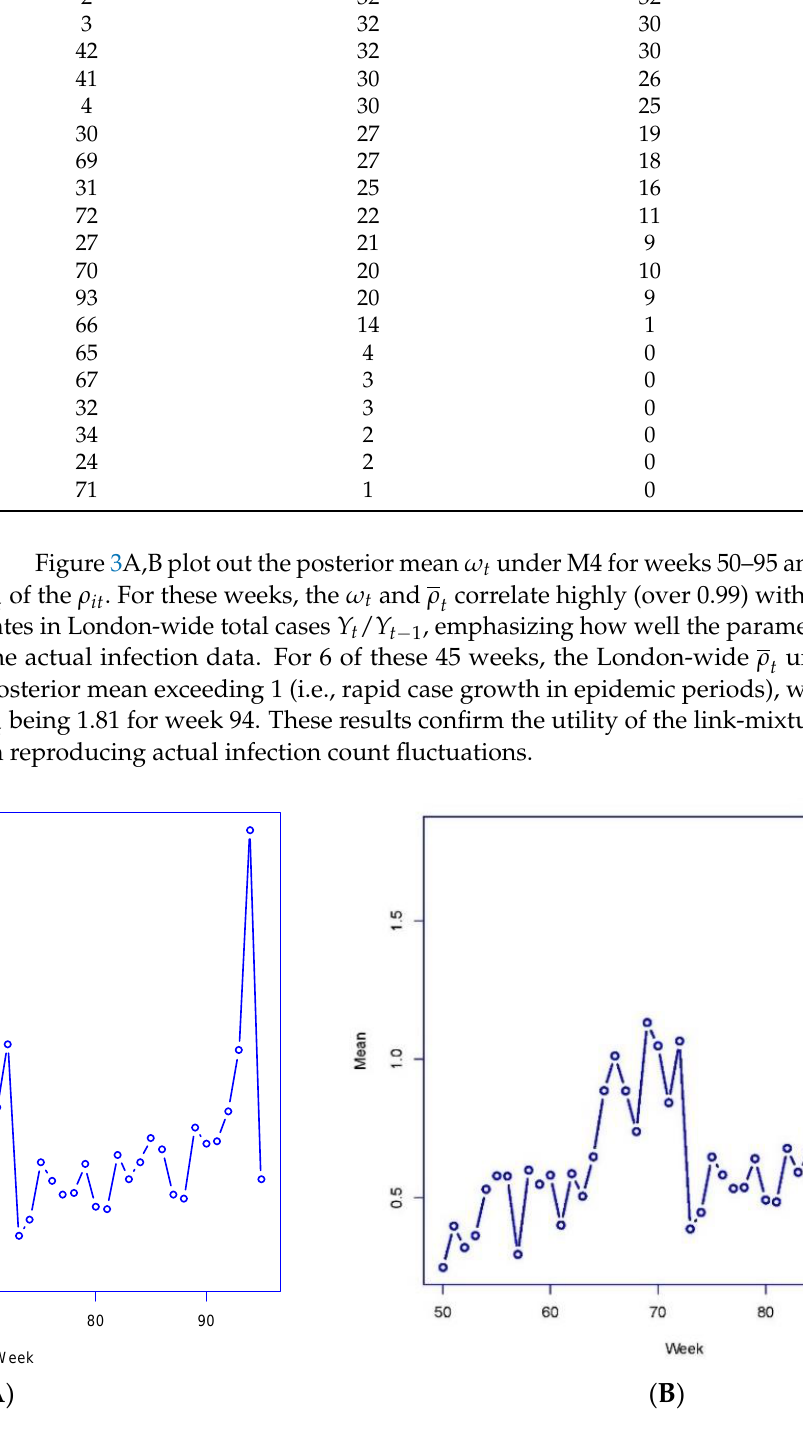
Figure 3. ( A ) posterior mean omega, London boroughs, ( B ) posterior mean 𝜌